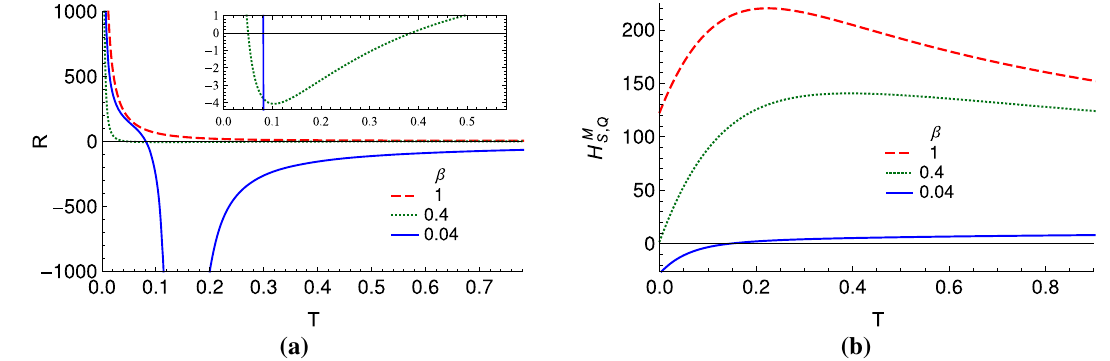
Fig. 13 The behavior of the Ruppeiner invariant R and H M Q = 0 .